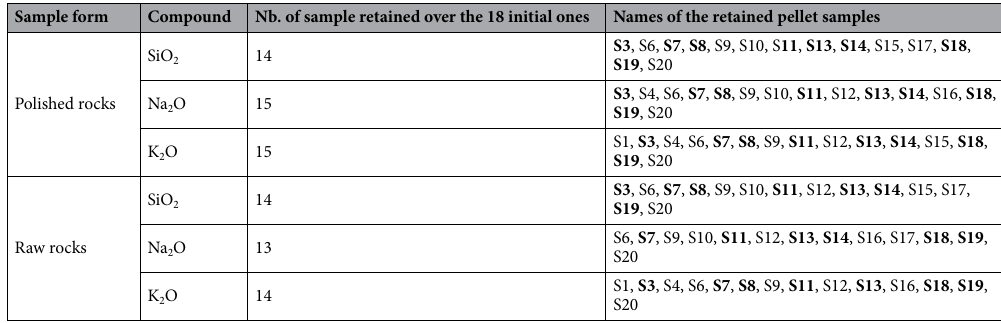
Table 5. Pellet samples retained in the final transfer learning training sample set by the optimization loop in the model training process. The counterpart pellets of the 8 training rock samples are highlighted in